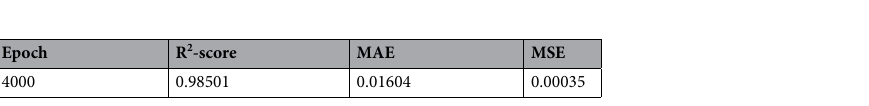
Table 4. The performance values of the learned MLP model tested with 30% of the 300 data of K value.